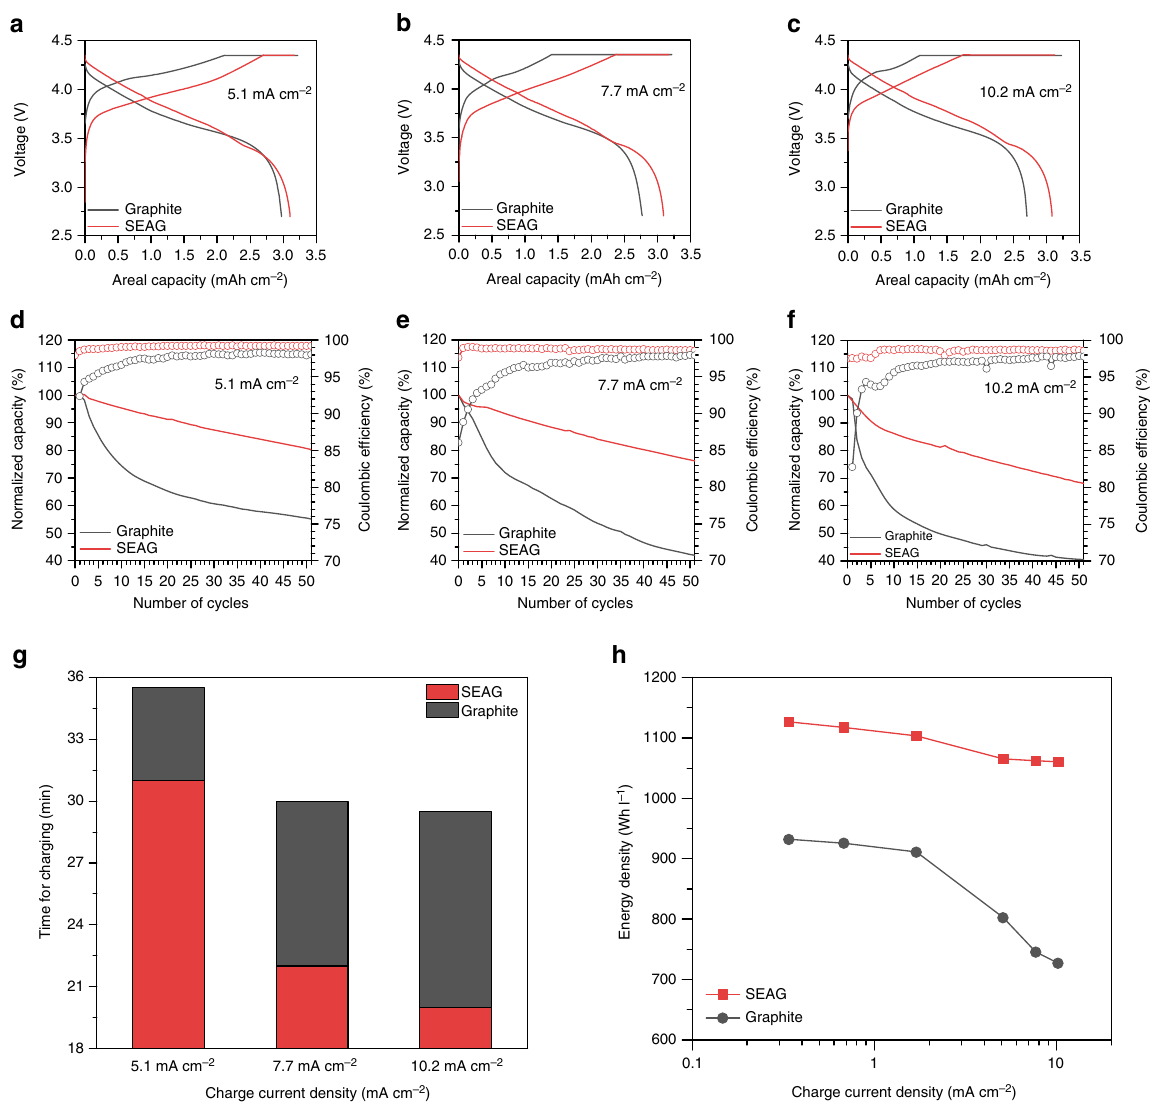
Fig. 5 Fast-charging performance of full-cells with anodes of graphite and the SEAG composite. Voltage pro fi les at charging current density of a 5.1 mA cm − 2 , b 7.7 mA cm − 2 , and c 10.2 mA cm − 2 . Fast-charging cycling performance in the potential range from 4.35 to 2.7 V for 50 cycles under increasing charging current densities of d 5.1 mA cm − 2 , e 7.7 mA cm − 2 , and f 10.2 mA cm − 2 . The discharging current density was fi xed at 1.7 mA cm − 2 in all cycling tests. g Time required to charge to 80% of SOC at each current density. h Plot of volumetric energy density vs. applied charging current density for graphite and SEAG. The volumetric energy densities were calculated from the total thickness of both the cathode and anode, considering the electrode volume expansion at the lithiated state during the fi rst cycle. In the electrode composed of SEAG, a volumetric energy density of 1060 Wh l − 1 was delivered under an applied charging current density of 10.2 mA cm −